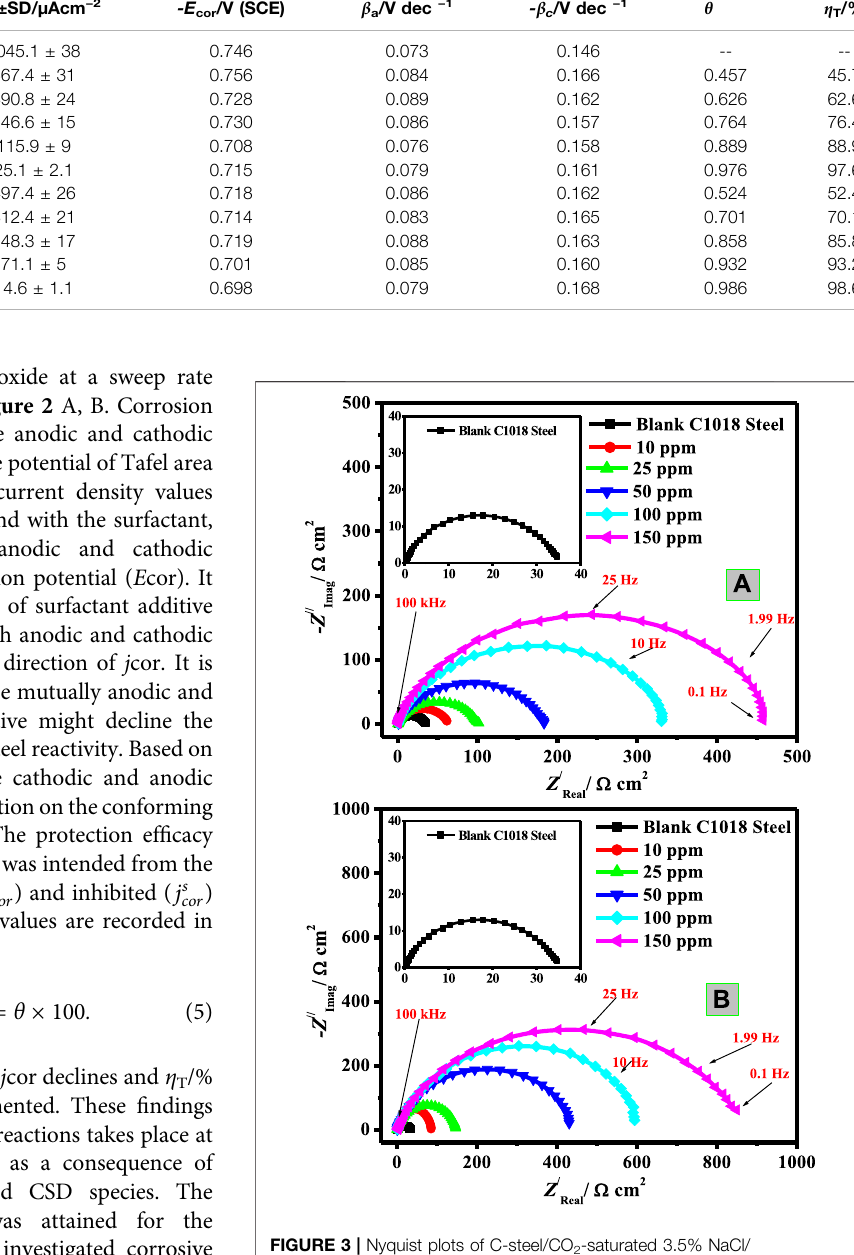
TABLE1| Tafelparametersandinhibitionef fi ciencyofC-steel in3.5%NaClsaturatedwithCO 2 intheabsenceandpresenceofdiversedosesofthepreparedsurfactantsat 50 ± 1 ° C. Inhibitor code